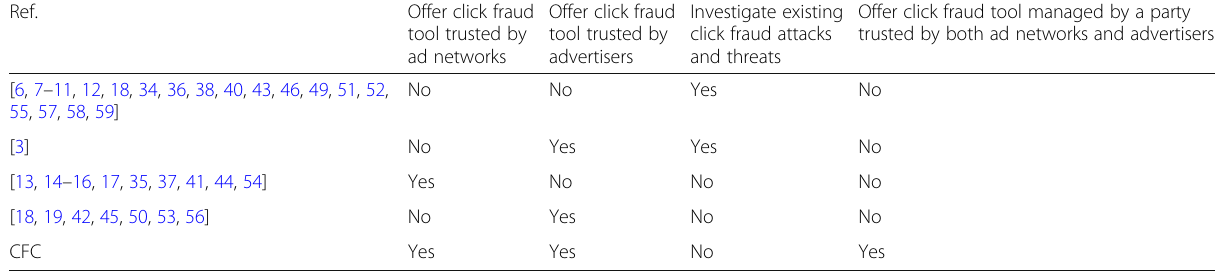
Table 1 Literature review summary vs. our work